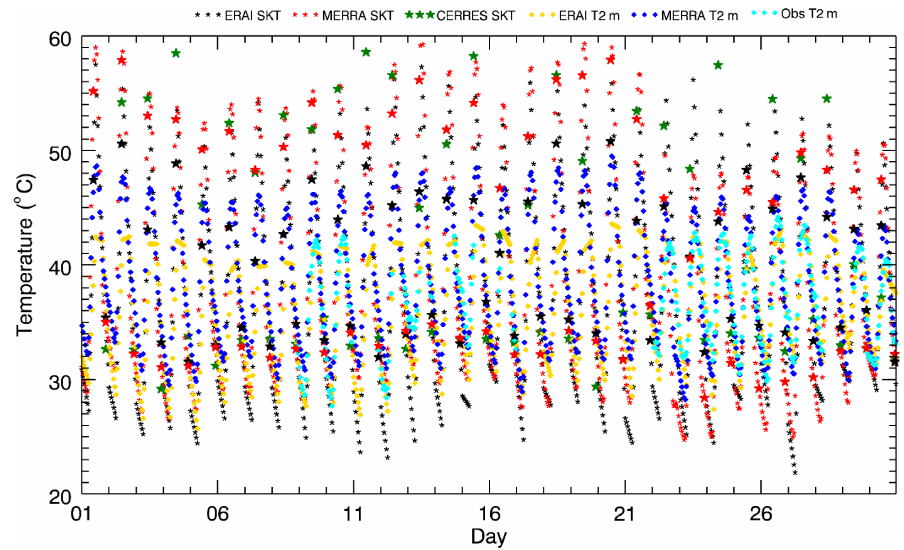
Figure 4. Surface skin temperature (SKT) (stars) and 2m air temperature (diamonds) at BBM. The bigger black and red stars denote ERA-I and MERRA skin temperature at the time steps when there are CERES